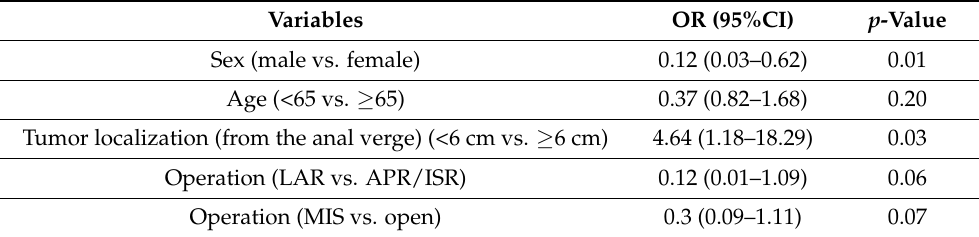
Table 4. Multivariate analysis of risk factors with a p -value <0.05 in the univariate analysis. Variables